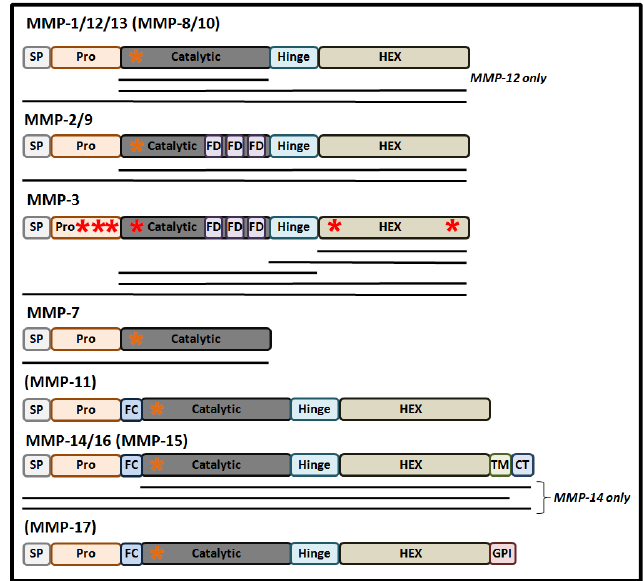
Figure 1. Domain structures of human matrix metalloproteinases (MMPs). Here the domain structures of nuclear MMPs (nMMPs) and MMPs, which have not been found in the nuclei but possess nuclear localization signals (NLSs) (placed in brackets), are presented. NLSs are indicated by the red asterisks (if their nuclear-trafficking properties have been proven experimentally) or by the orange asterisks (if the NLS has been identified by bioinformatics alone). Horizontal lines indicate the isoforms of MMPs, which have been found in nuclei. SP, signal peptide; Pro, pro-domain; FC, furin cleavage site; FD, fibronectin domain; HEX, hemopexin-like domain; TM, trans-membrane domain; CT, cytoplasmic tail; GPI, glycosylphosphatidylinositol.